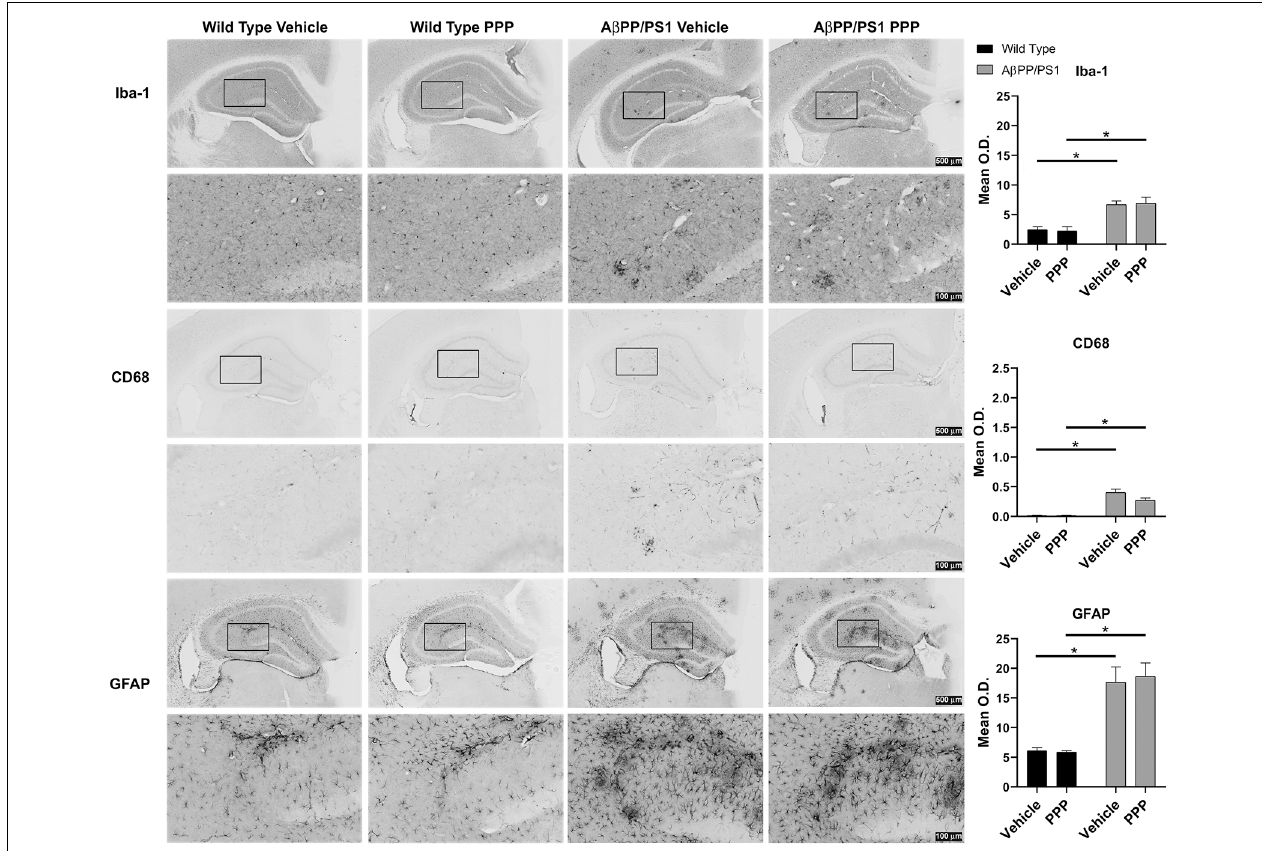
FIGURE 2 | IGF-1R inhibitor treatment did not alter gliosis immunoreactivity in A β PP/PS1 mice. IHC was performed from the vehicle (DMSO) and PPP (1 mg/kg, 7 days) treated WT and A β PP/PS1 mouse brains using anti-Iba1 (microglial marker), anti-CD68 (microglia marker), and anti-GFAP (astrocyte marker) antibodies and mean optical density was measured. Antibody binding was visualized using Vector VIP as the chromogen. Data are mean O.D. ± SEM, * p < 0.05 ( n = 6 animals/condition). Two-way ANOVA indicate Iba-1 staining F (1,20) = 0.09309 and p (interaction) = 0.7634; CD68 staining F (1,20) = 3.775 and p (interaction) = 0.0662; GFAP staining F (1,20) = 0.1156 and p (interaction) = 0.7374. The errors from comparisons of several pairs of means in the experiment were adjusted using Tukey’s multiple comparison tests. Representative hippocampal images are shown.